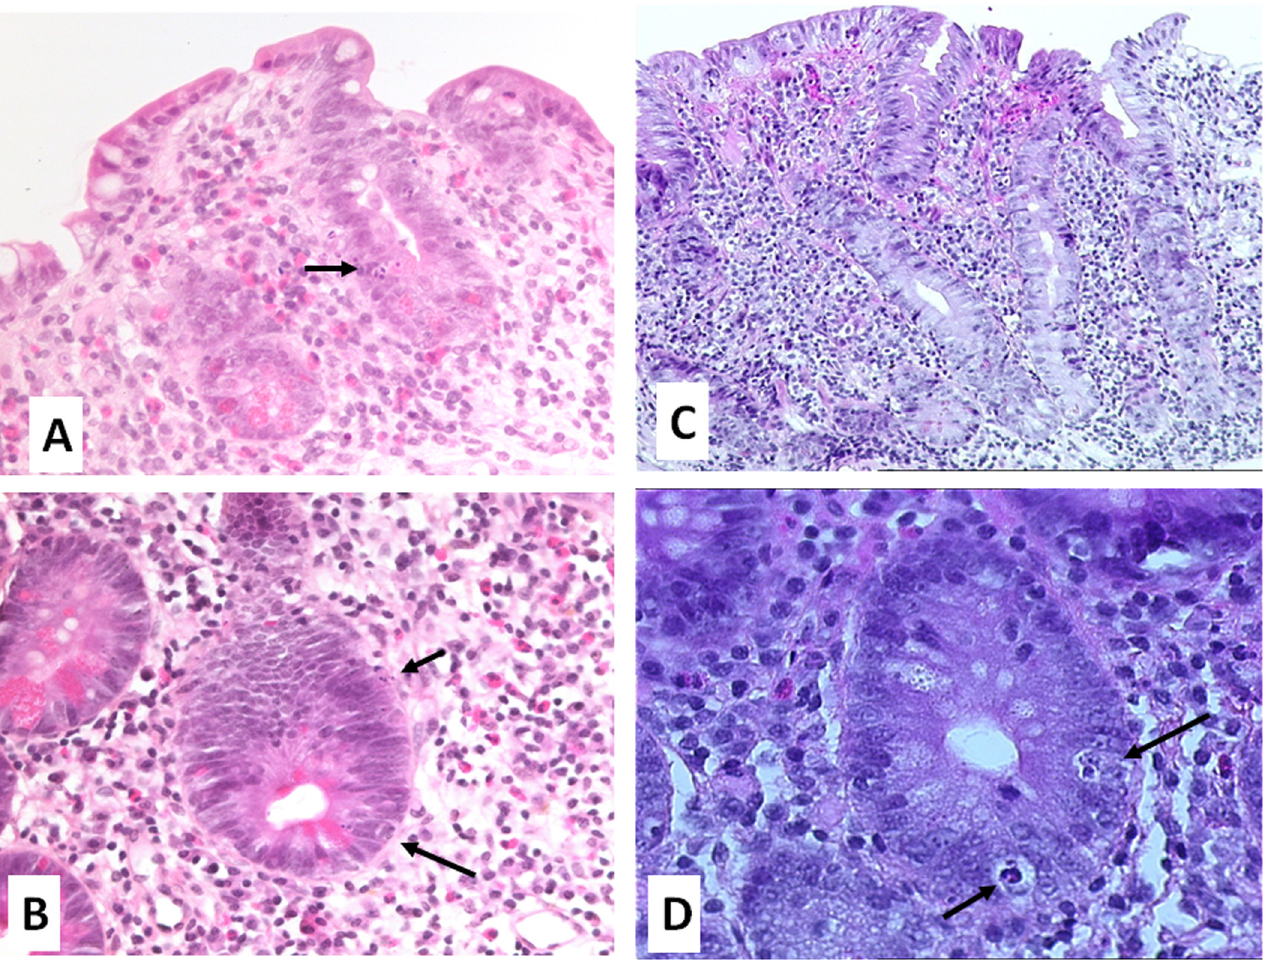
Fig 1. H&E staining of the duodenal biopsies of one patient treated with Olmesartan (patient 2) (A, B) and of one patient with AIE (patient 7) (C, D) showing subtotal villous atrophy (A, C: original magnification x 100) with glandular apoptosis (B, D: original magnification